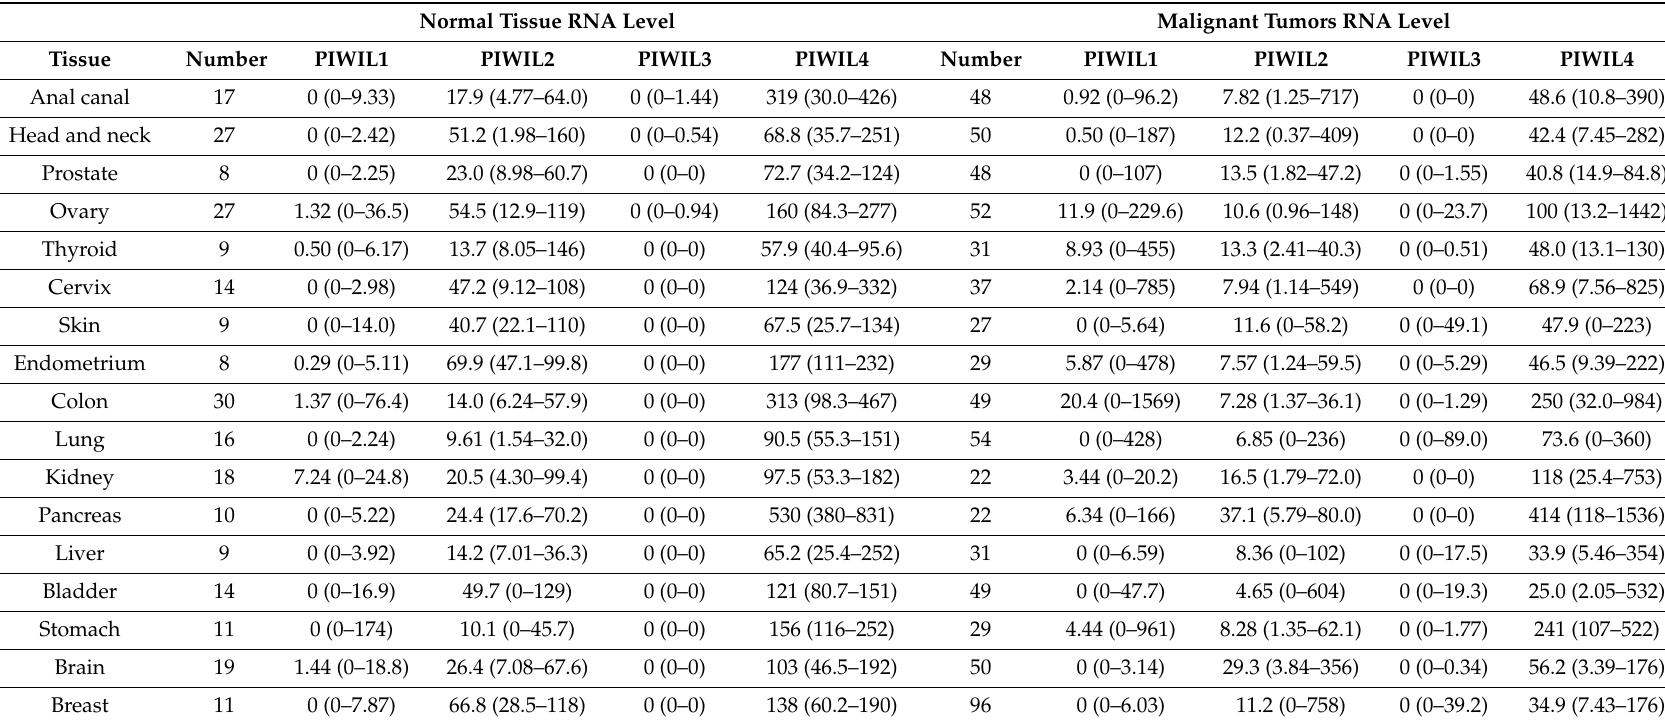
Table 1. PIWIL1-2-3-4 mRNA expression levels in a panel of normal tissues and corresponding malignant tumors. Normal Tissue RNA Level Malignant Tumors RNA